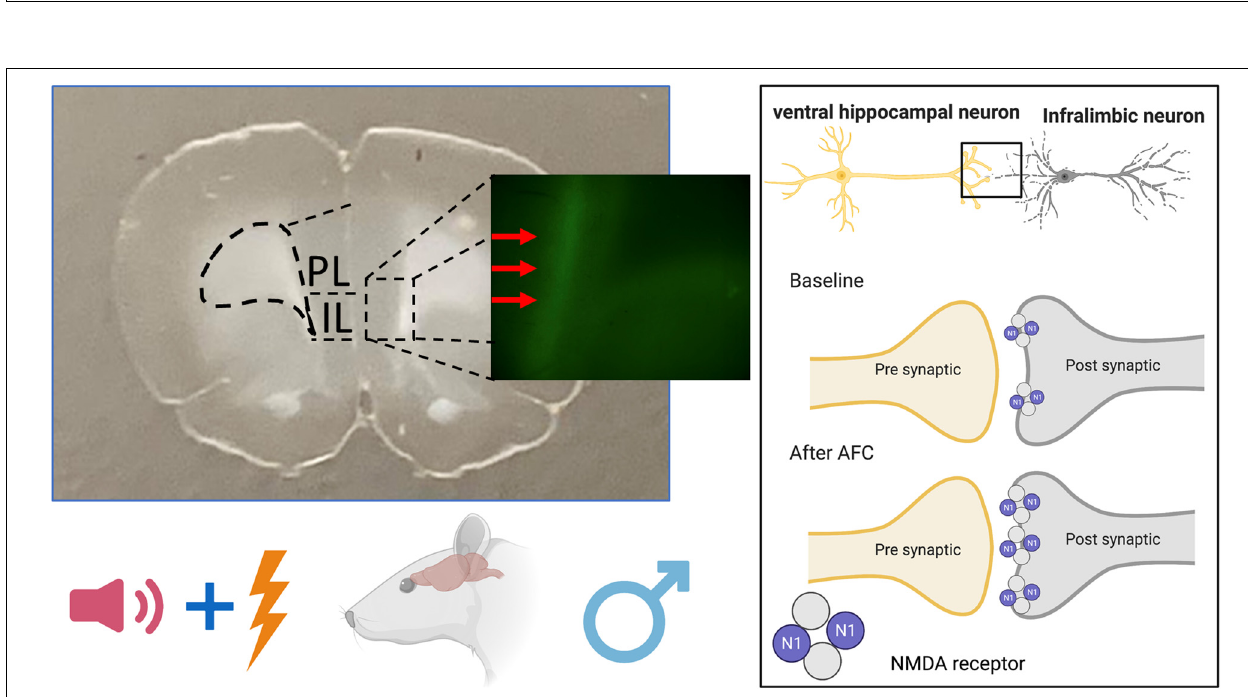
FIGURE 8 | Schematic diagram of NMDAR changes after auditory fear conditioning in male rat brain. Associative fear learning increases NMDAR on ventral hippocampal projections to the infralimbic cortex.